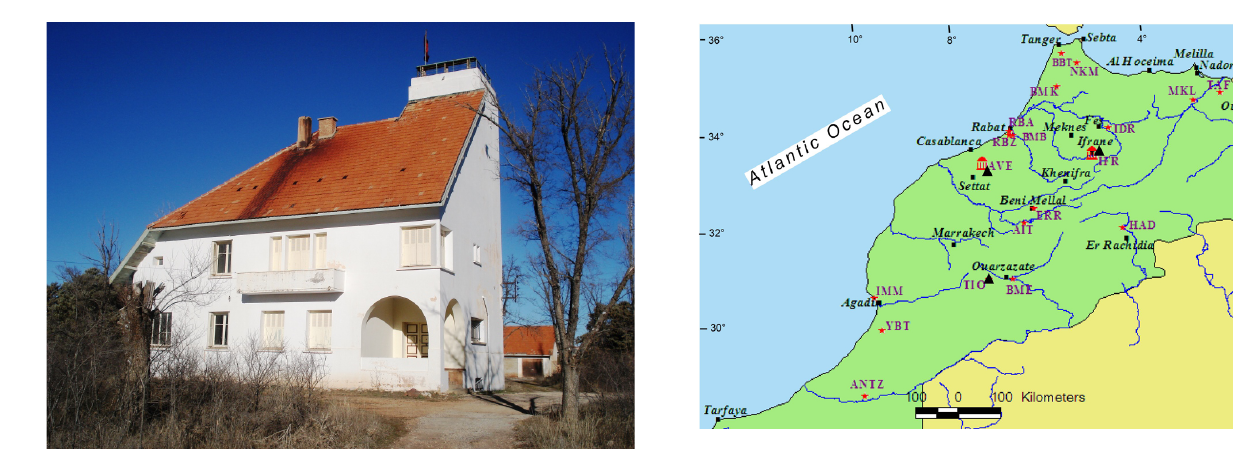
Figure A1. Location of the observatories and stations of the Institut Scientifique in Morocco. Observatories: AVE (Averroes at Berrechid); IFR (Ifrane); TIO (Tiouine); and ANT (Aouinat Torkoz). Other stations were mainly active in the 1970s–1980s. Tri- angles represent western Mediterranean